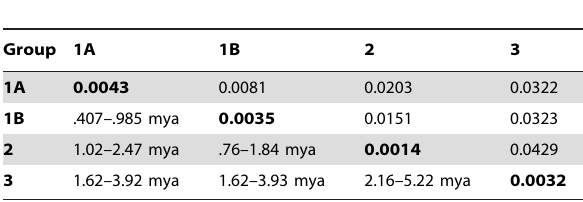
Table 3. Kimura Two Parameter distance within (diagonal, bold type) or among ITS2 groups (above diagonal) and time separated (below